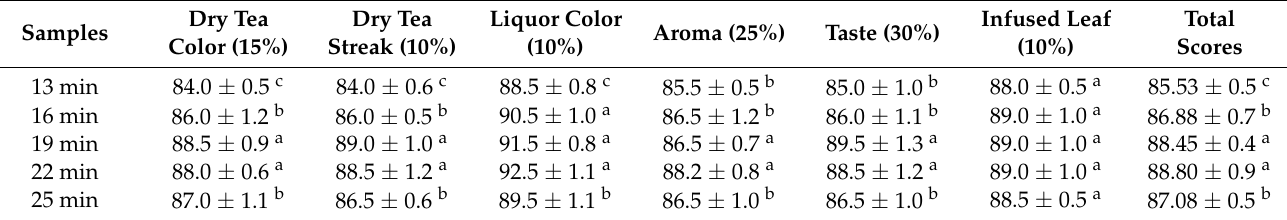
Table 1. Sensory quality scores of the YAYT with different roasting